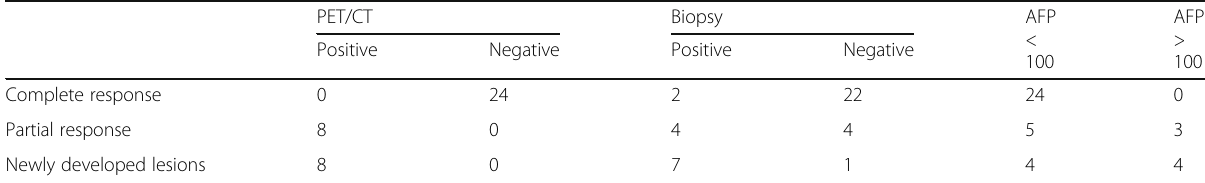
Table 6 PET/CT, biopsy results, and AFP values per response of all studied patients